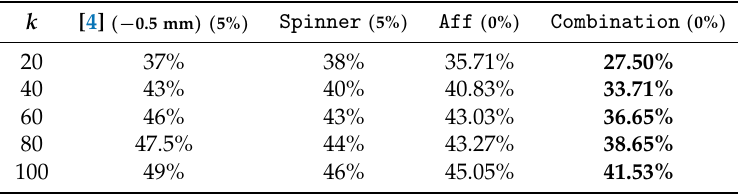
Table 2. Comparison to prior work on LiveJournal . The main entries are the ratio of edges cut by the clustering over the total number of edges in the graph. The number of clusters is denoted by k . Numbers in parentheses are permissible imbalance (Best results in each row are typeset in bold for easier